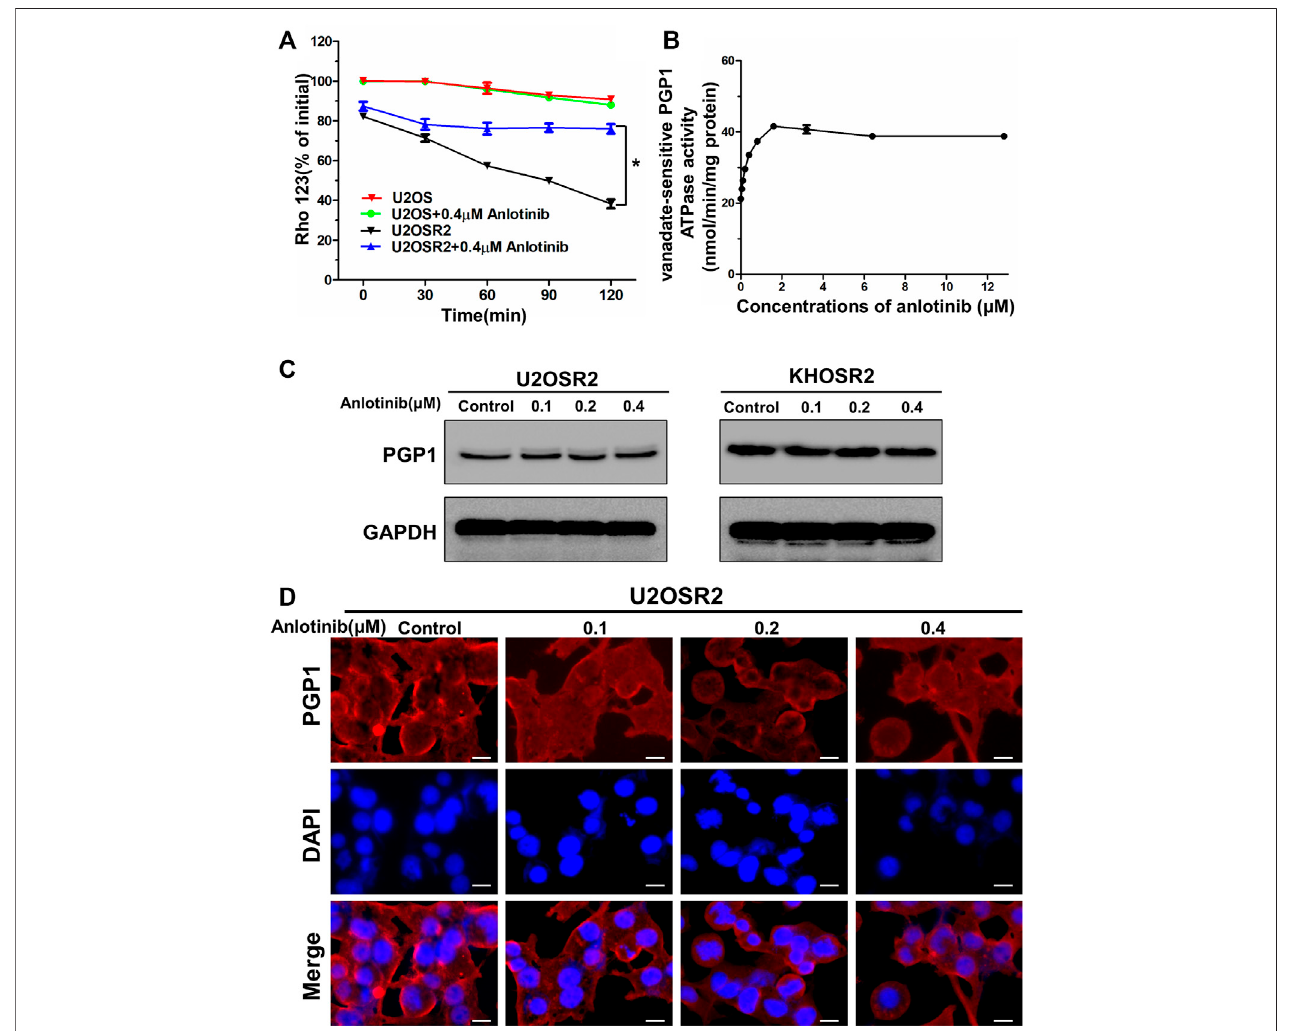
FIGURE5| Effectofanlotinibontheef fl uxofRho-123andontheATPaseactivityandexpressionlevelofPGP1inmultidrug-resistantosteosarcomacells. (A) .Thetime courseofRho-123ef fl uxfrommultidrug-resistantosteosarcomacellswasmeasuredinthepresenceorabsenceof0.4 μ Manlotinib.Datarepresentthemean ± SDofatleast three independent experiments. * p < 0.05; ** p < 0.01. (B) . Vanadate-sensitive PGP1 ATPase activity was evaluated in the presence of the indicated concentrations of anlotinib. (C) . Effect of 24 h of treatment with the indicated concentrations of anlotinib on the expression level of PGP1 in multidrug-resistant osteosarcoma cells. (D) . Effect of 24 h of treatment with the indicated concentrations of anlotinib on the subcellular localization of PGP1 in U2OSR2 cells. Scale bars (cid:1) 20 μ m.